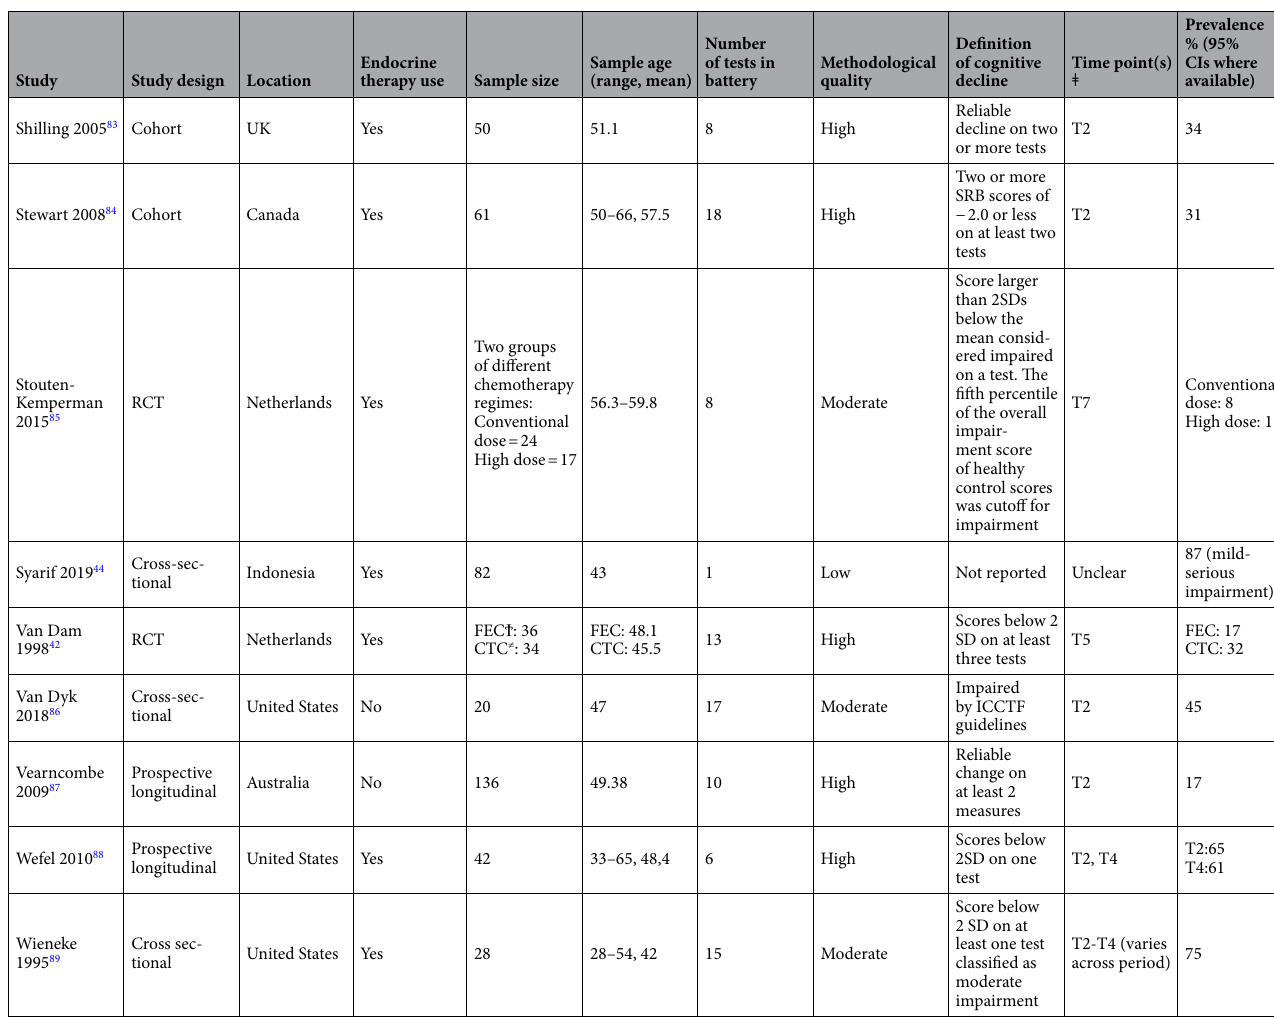
Table 3. Summary of included studies employing objective neuropsychological testing to assess cognitive